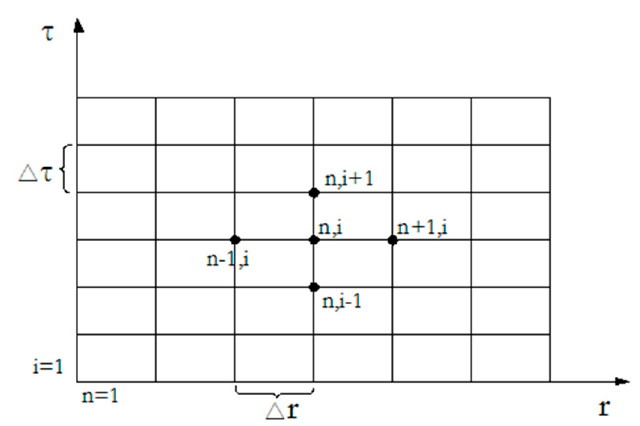
Figure 1. Time–space regional discretization of one-dimensional unsteady heat conduction. Where r is the space coordinate and ∆ r is the space step. τ represents the time coordinate and ∆ τ is the time step. (n, i) is the position of a node on the time–space region, and the corresponding temperature is recorded as t i n